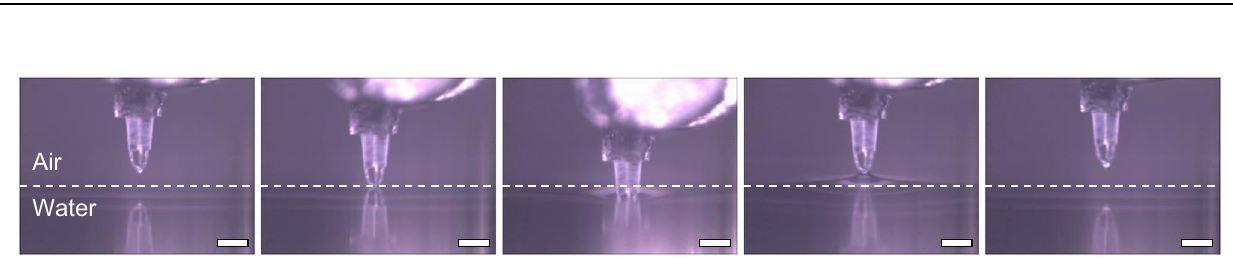
whenasingleclusteredstructureofthefabricated Salvinia -inspiredsurfacescomes into contact with water. Scale bars represent 300 μ m.